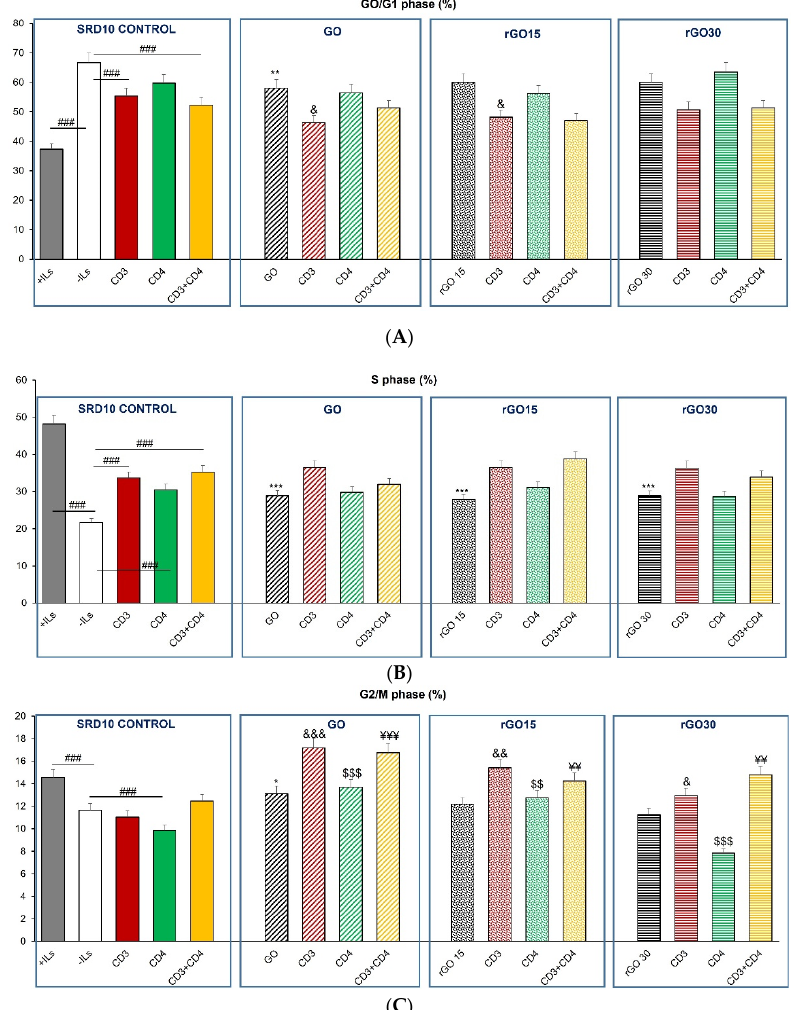
Figure 5. ( A ) Effect of GO, rGO15 and rGO30 on the percentage of G 0 /G 1 phase of CD4 + Th2 SR.D10 cell line after 24 h of treatment with 5 µ g/mL of these nanostructures, evaluated by flow cytometry under basal and stimulated conditions. The control cells were cultured in the presence of stimuli without material (SR.D10 CONTROL) in parallel. Statistical significance: ### p < 0.005 (compared to control cells without material cultured in the absence of ILs); ** p < 0.01 (compared to control cells without material cultured in the absence of ILs); & p < 0.05 (compared to control cells activated through CD3 in the absence of ILs). ( B ) Effect of GO, rGO15 and rGO30 on the percentage of the S phase of CD4 + Th2 SR.D10 cell line after 24 h of treatment with 5 µ g/mL of these nanostructures, evaluated by flow cytometry under basal and stimulated conditions. The control cells were cultured in the presence of stimuli without material (SR.D10 CONTROL) in parallel. Statistical significance: ### p < 0.005 (compared to control cells without material cultured in the absence of ILs); *** p < 0.005 (compared to control cells without material cultured in the absence of ILs). ( C ) Effect of GO, rGO15 and rGO30 on the percentage of G 2 /M phase of CD4 + Th2 SR.D10 cell line after 24 h of treatment with 5 µ g/mL of these nanostructures, evaluated by flow cytometry under basal and stimulated conditions. The control cells were cultured in the presence of stimuli without material (SR.D10 CONTROL) in parallel. Statistical significance: ### p < 0.005 (compared to control cells without material cultured in the absence of ILs); * p < 0.05 (compared to control cells without material cultured in the absence of ILs); & p < 0.05, && p < 0.01, &&& p < 0.005 (compared to control cells activated through CD3 in the absence of ILs); $$ p < 0.01, $$$ p < 0.005 (compared to control cells activated through CD4 in the absence of ILs); ¥¥ p < 0.01, ¥¥¥ p < 0.005 (compared to control cells activated through CD3 and CD4 in the absence of